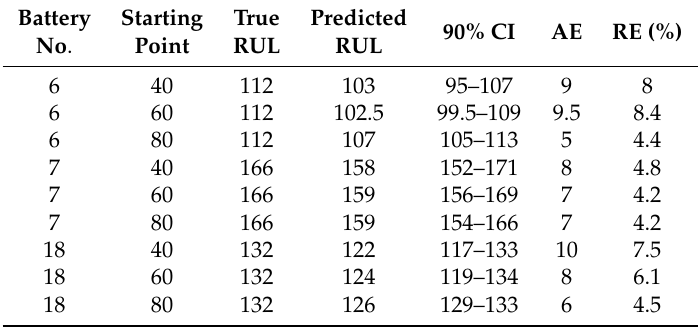
Table 3. Quantitative results for RUL prediction with different starting points from other battery